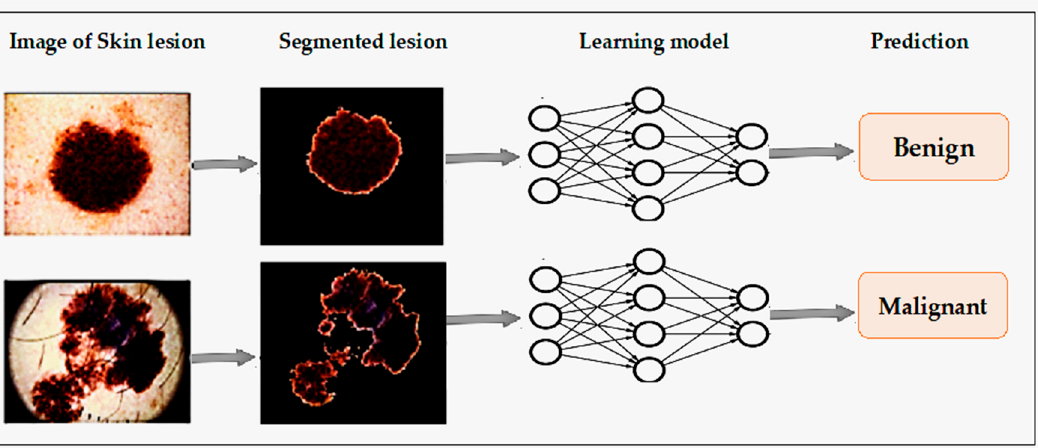
Figure 6. Skin cancer diagnosis using CNN [37]. Table 4. A comparative analysis of skin cancer detection using CNN-based